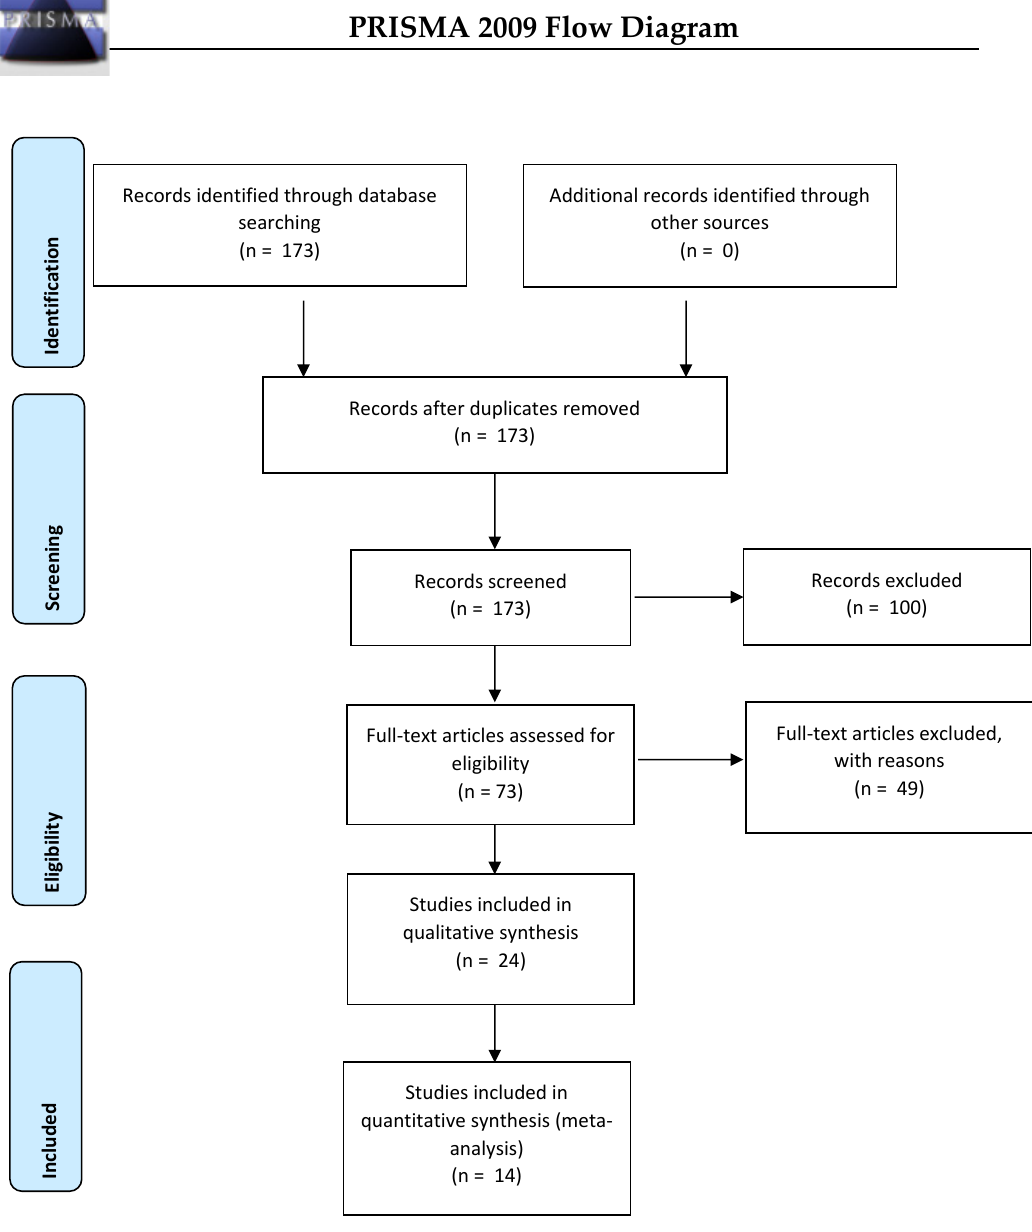
Figure 1. Flow diagram for the inclusion and exclusion of studies.